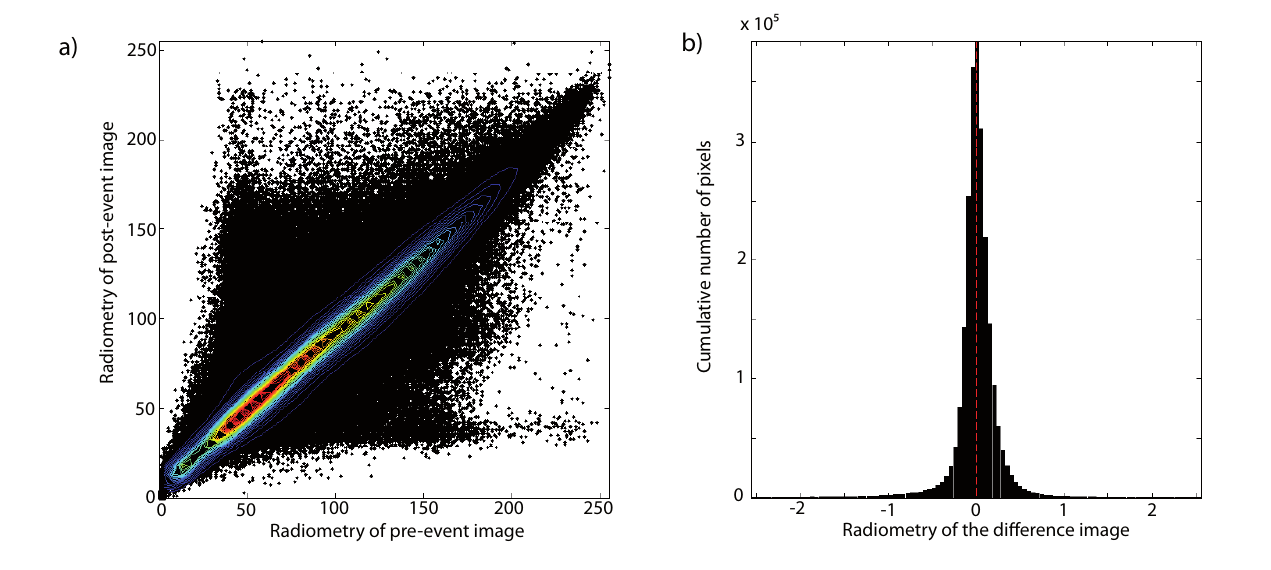
Figure 2. ( a ) Diagram showing the radiometry of each pixel for the pre- and post-event images (black points). The color lines represent the iso-level of pixel density. We notice that most pixels are situated along the line x = y. This shows that most pixels have similar radiometric values in the pre- and post-image. ( b ) Histogram of the difference image once the images have been